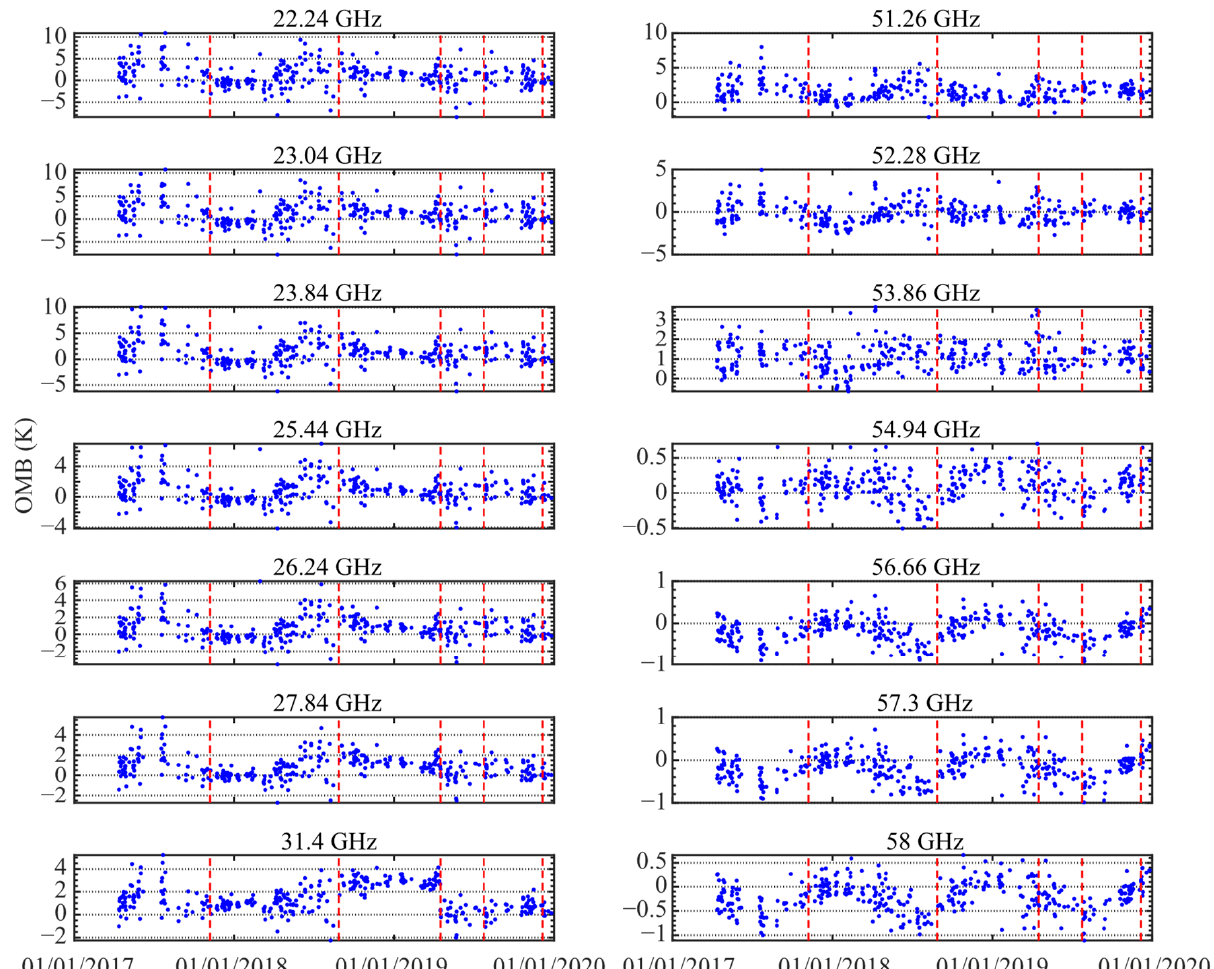
Figure 2. Time series diagrams of OMB of 14 channels in the clear sky (the red dashed lines are the dates of MWR calibration).